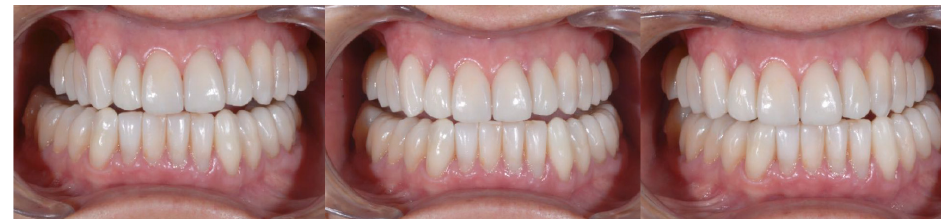
Figure 12. Physiological occlusal dynamics in protrusion and lateral movements.